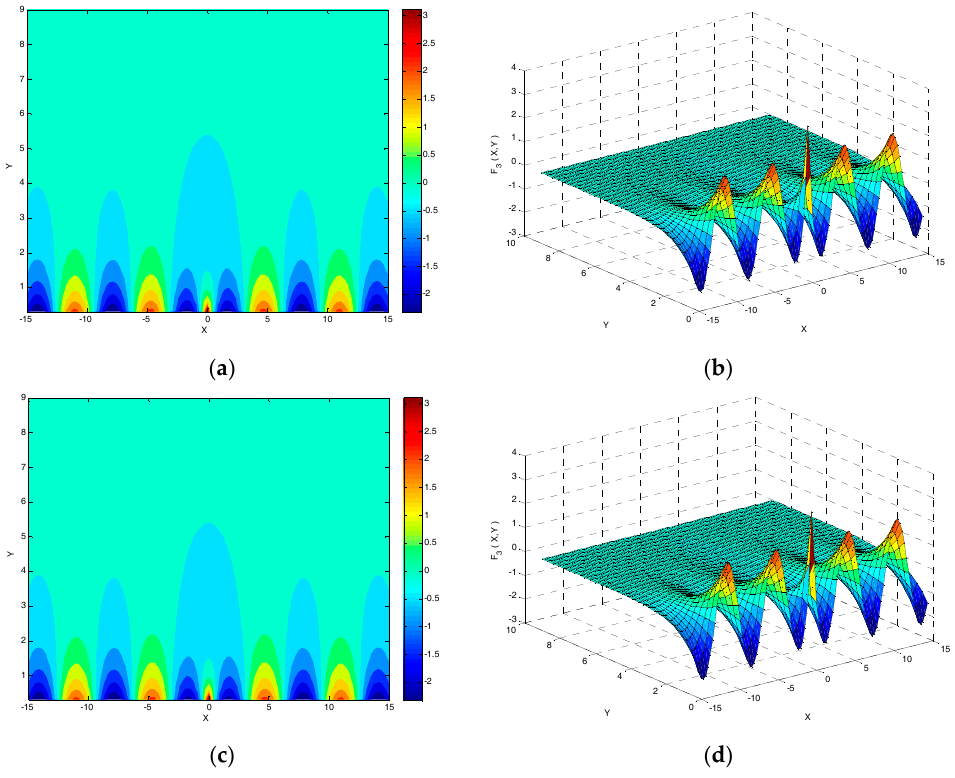
Figure 4. Comparison of the singular function F 3 ( X , Y ) calculated by the two methods. For captions of the subplots please refer to Figure 2.